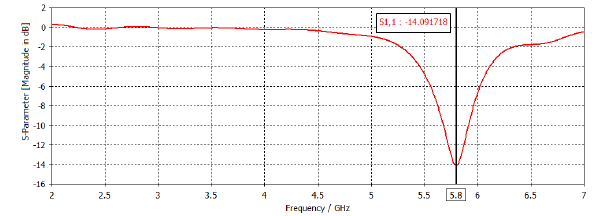
Figure 18. Return loss for Dupont-951.